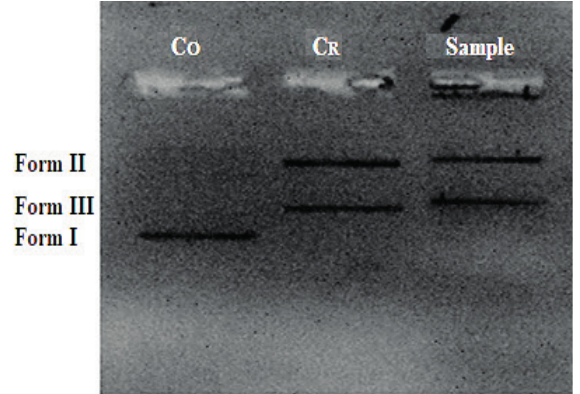
Figure 3 - Effect of n -BuOH extract of C. sphaerocephala on the safety of 46966 plasmid DNA against oxidative damage caused by UV-photolysed H O . C : untreated non- 2 2 o irradiated DNA. C : untreated UV-irradiated DNA Sample : R DNA and UV-irradiated treated with n -BuOH extract.